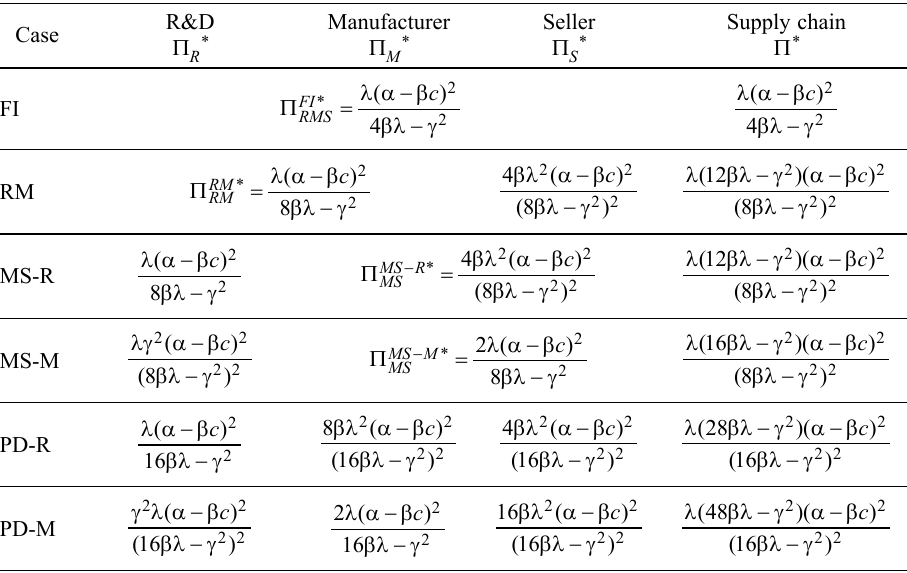
Table 2. Solution summary: